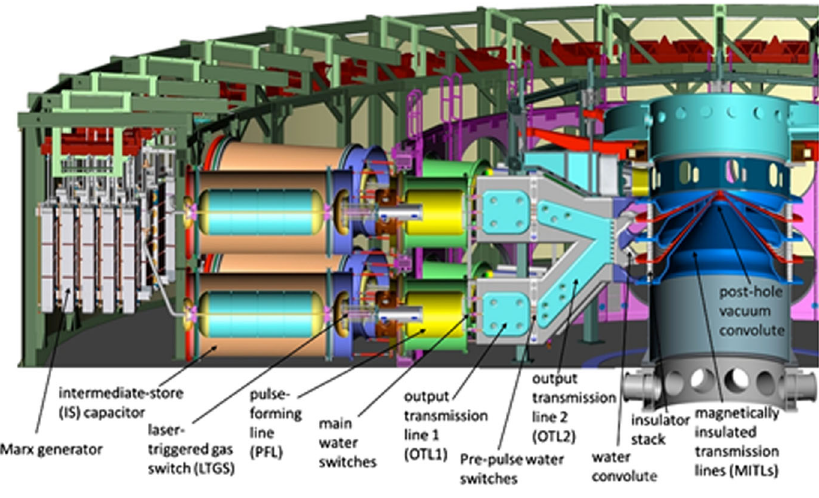
FIG. 1. Cross-sectional view indicating the major components of the Z